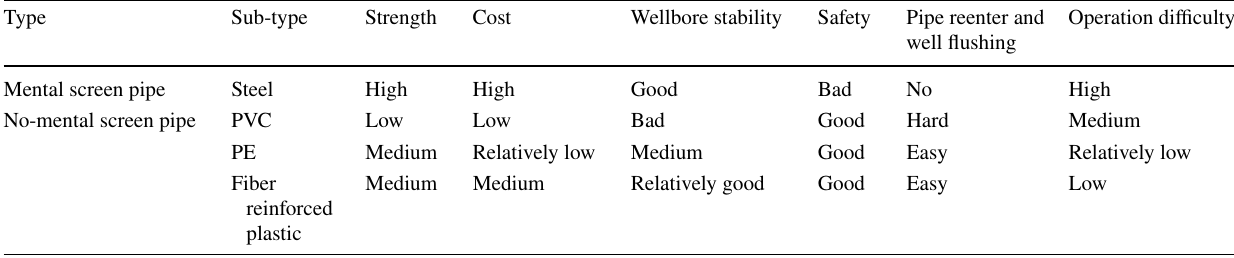
Table 7 Different screen pipes, after Huang et al. (2012), Shi et al. (2013) and Bi et al. (2016)